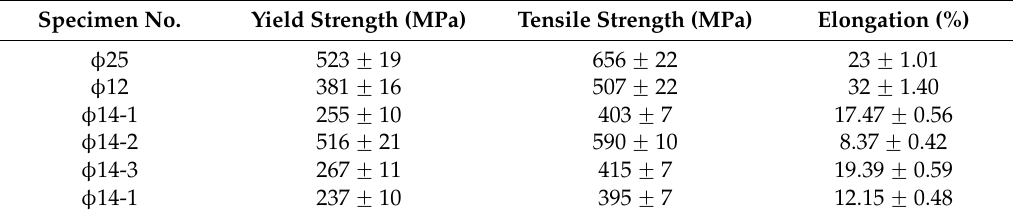
Table 2. Test results of sampled rebar